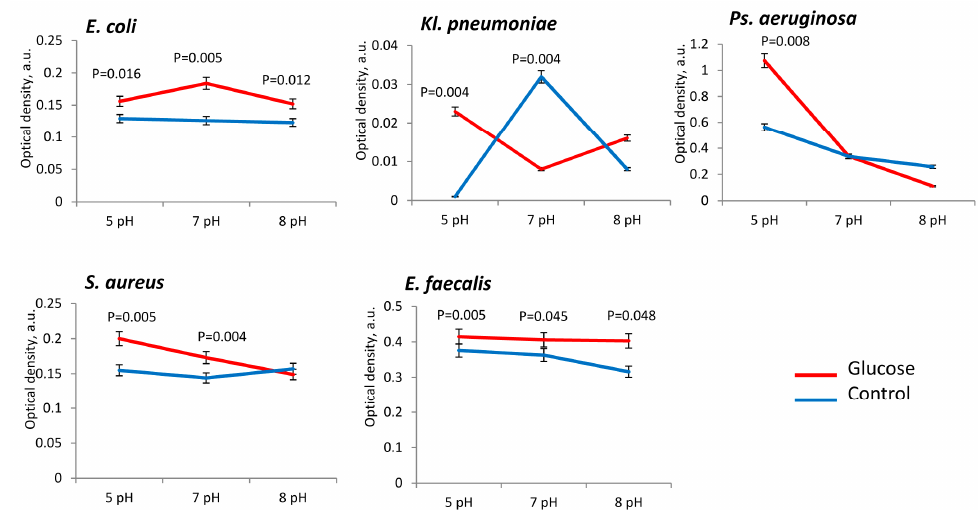
Figure 2. Biomass production of uropathogenic microorganisms is in fl uenced by pH and the presence of glucose in PBS.